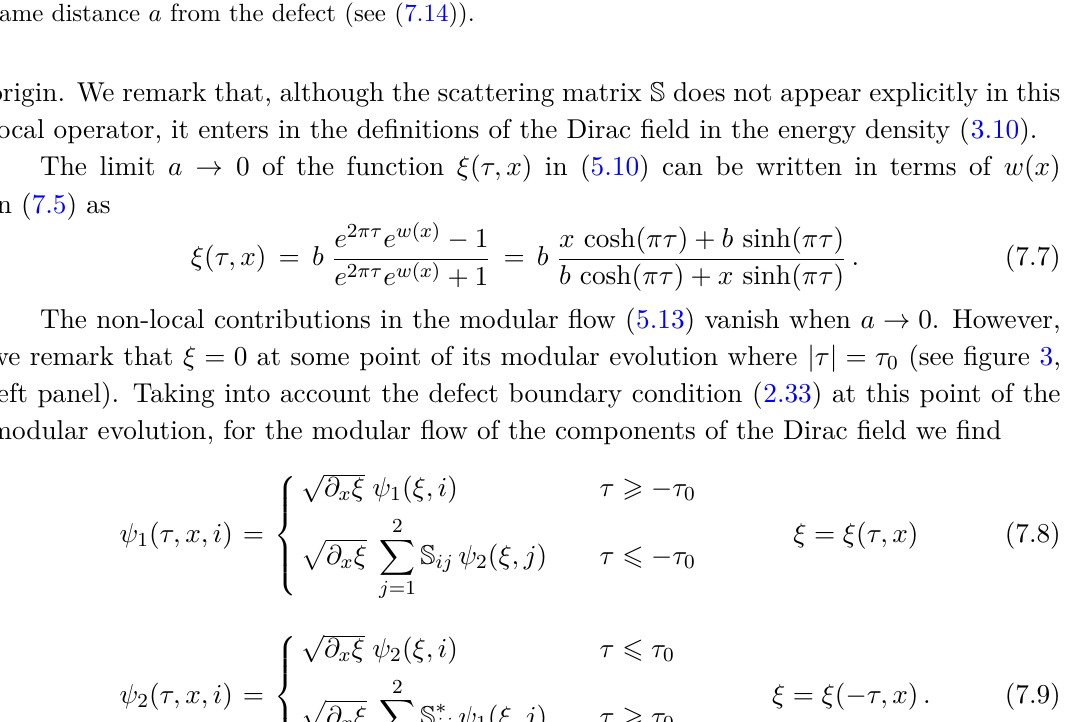
Figure 3 . Evolutions of the arguments of the fields along the local modular flows. Left: interval of length 2 b with the defect in its center (see (7.8) and (7.9)). Right: two semi-infinite lines at the same distance a from the defect (see